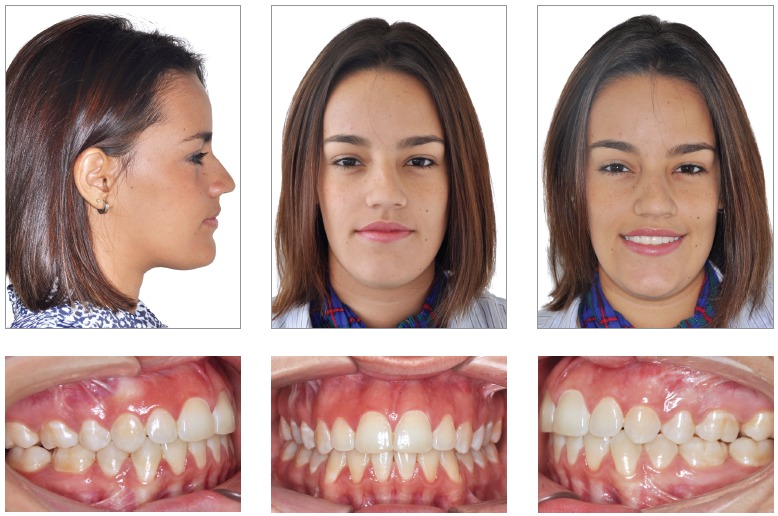
Final photographs.